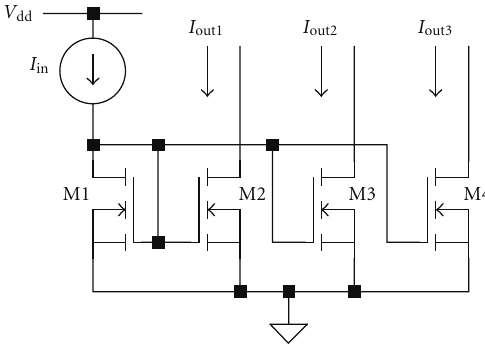
Figure 5: NMOS current replication circuit.